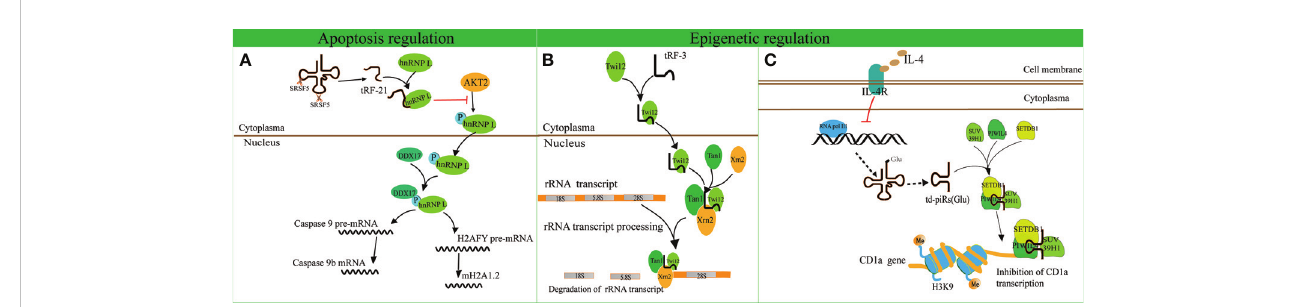
FIGURE 3 Apoptosis and epigenetic regulation by tRNA-derived fragments (tRFs). (A) The interaction of tRF-21-VBY9PYKHD and hnRNP L inhibits the phosphorylation of hnRNP L mediated by AKT2 and promotes the formation of the hnRNP L and DDX17 complex. This complex splices Caspase 9 and mH2A1 pre-mRNAs into Caspase 9b mRNA and mH2A1.2 mRNA. (B) tRF-3 translocates into the nucleus with the assistance of Twi12. The Twi12-tRF-3 complex binds to the exonuclease Xrn2 and Tan1 to form a complex, which plays important roles in rRNA processing. (C) IL-4 decreases the production of tRNA Glu followed by the downregulation of td-piR, which assembles with PIWIL4 and recruits SETDB1, SUV39H1, and HP1 b to the promoter of CD1a mRNA and facilitates methylation of H3K9 histone followed by inhibition of CD1a